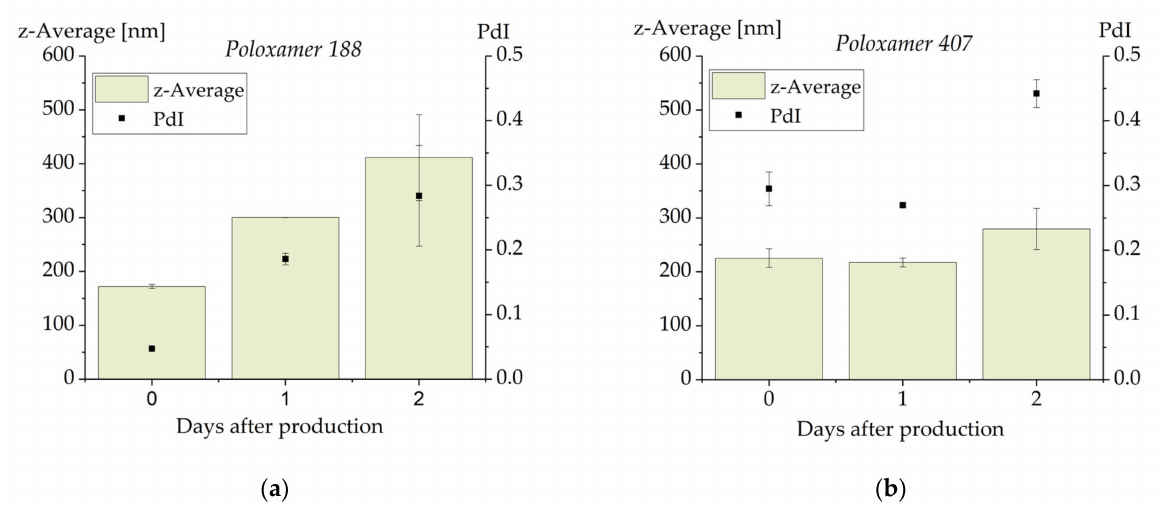
Figure 8. Particle size and PdI of emulsions containing pure cannabidiol as dispersed phase and stabilized with poloxamer 188 ( a ) or poloxamer 407 ( b ). The results represent the mean values of n = 2. The error bar shows the upper and lower measured